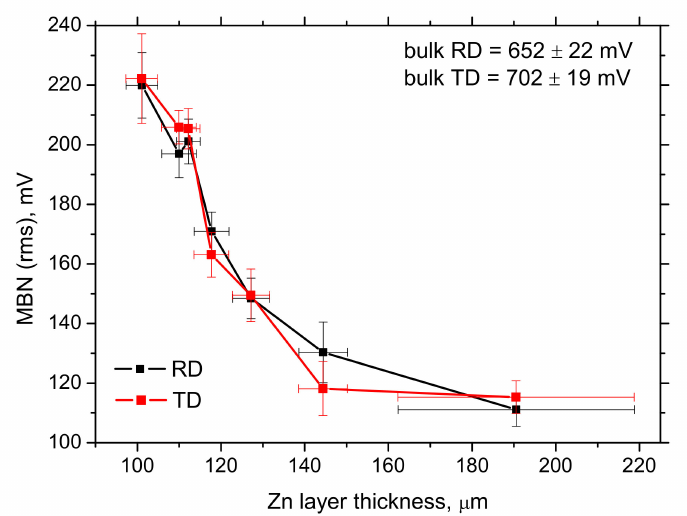
Figure 9. Evolution of MBN along with increasing Zn coating (layer) thickness (obtained from the MO).